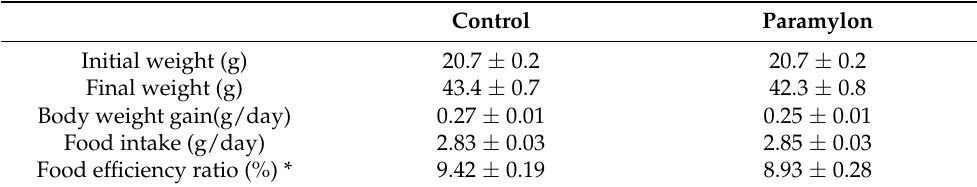
Table 2. Body weight gain, food intake, food efficiency ratio.